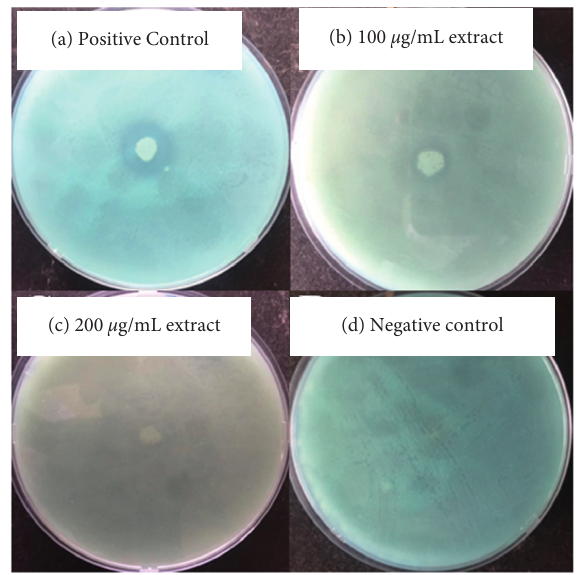
Figure 3: The effects of the O. reticulata ethyl acetate extract on the production of extracellular proteases by S. aureus . A distinct halo is produced for the positive control (a), less distinct haloes are produced on plates containing 100 µ g/mL (b) and 200 µ g/mL (c) of the ethyl acetate extract while no growth or haloes are obtained for the negative control (d) after 24 h of incubation. Table 2: The proteolytic activities of the extracellular proteases produced from S. aureus on BCG-skim milk agar plates: A, B, C, and D. Plate Colony diameter (mm) Colony diameter+halo (mm)